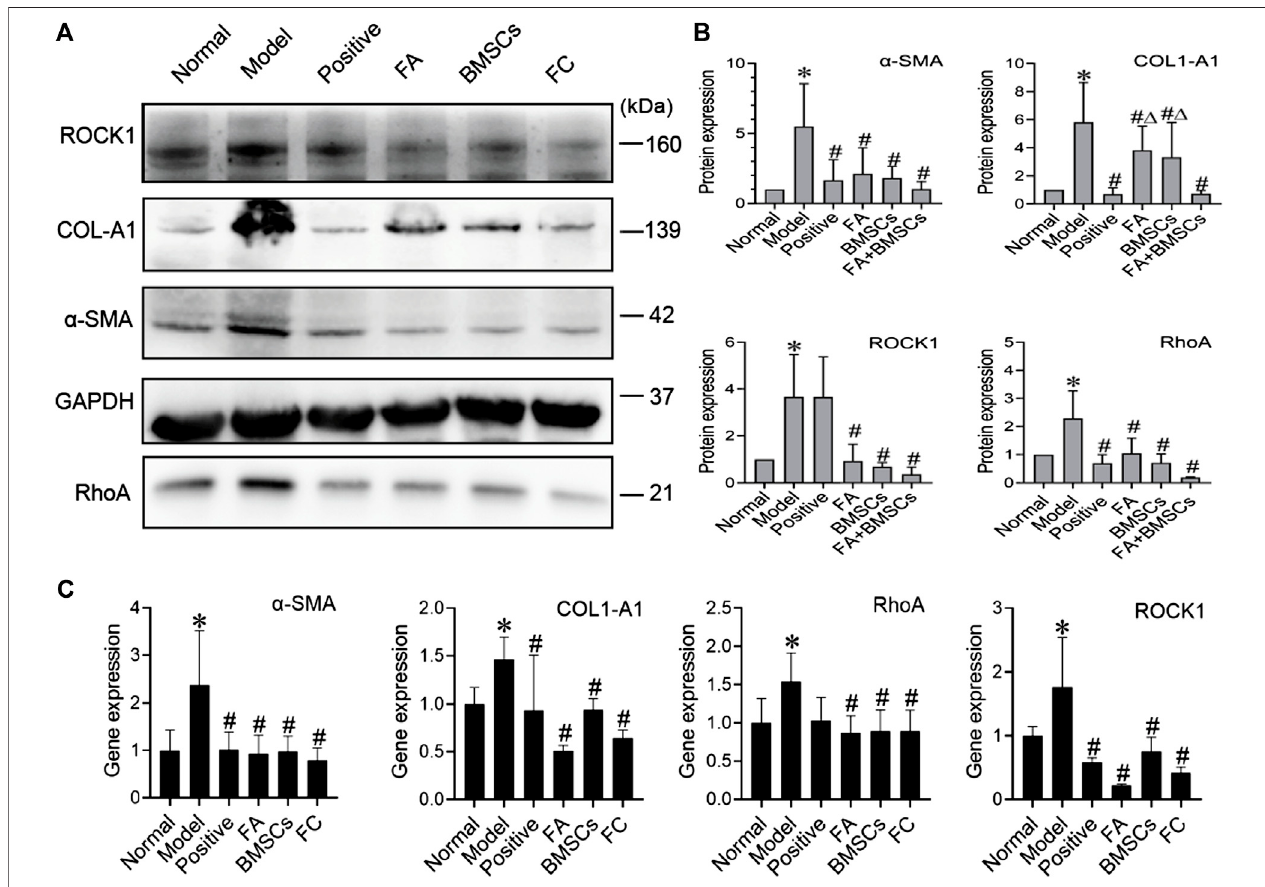
FIGURE 2 | (A , B) Western blot and cumulative densitometric analyses of ROCK1 (160 kDa), COL1-A1 (139 kDa), α -SMA (42 kDa), GAPDH (37 kDa), and RhoA (21 kDa)inliversfromeachgroup(normal,model,positive,FA,BMSCs,FC).Dataarepresentedasthemean±SEM( n =3independentexperiments,Two-wayANOVA; * p < 0.05versusthenormalgroup; # p < 0.05,versusthemodelgroup; Δ p < 0.05,versustheFCgroup); (C) qRT-PCRanalysisfor α -SMA,COL1-A1,ROCK1, and RhoA in rat livers. Data are presented as the mean ± SEM ( n = 3 independent experiments, Two-way ANOVA; * p < 0.05 versus the normal group; # p < 0.05 versus the model